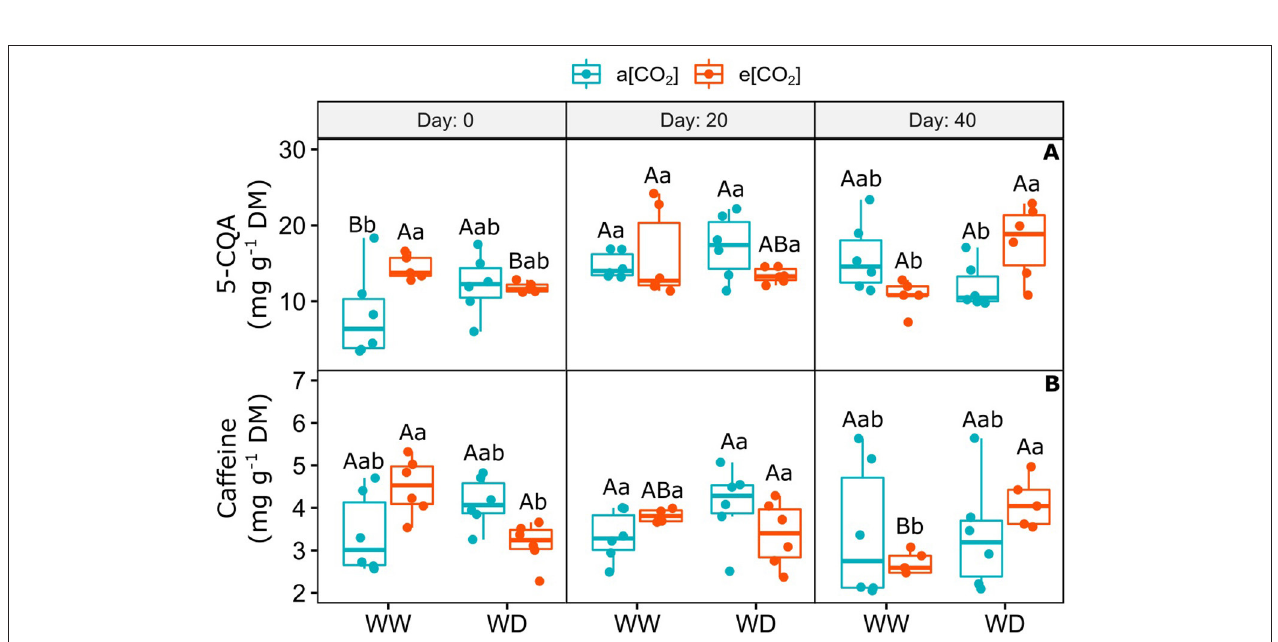
FIGURE 5 | (A) Content of 5-O-caffeoylquinic acid and (B) Caffeine in leaves of C. arabica plants exposed to ambient [CO 2 ] under well-watered and water deficit (a[CO 2 ] + WW and a[CO 2 ] + WD, respectively) and elevated [CO 2 ] under well-watered and water deficit (e[CO 2 ] + WW and e[CO 2 ] + WD, respectively) conditions on day 0, 20, and 40 after water deficit imposition in the OTC. Boxes represent the median and first and third quartiles, symbols represent individual samples ( n = 6–5 biological replicates). Different capital letters represent significant differences between sampling day in the same water and [CO 2 ] condition, whereas different lowercase letters represent significant differences between water and [CO 2 ] conditions in the same sampling day according to Tukey’s test at 5% of probability ( P ≤